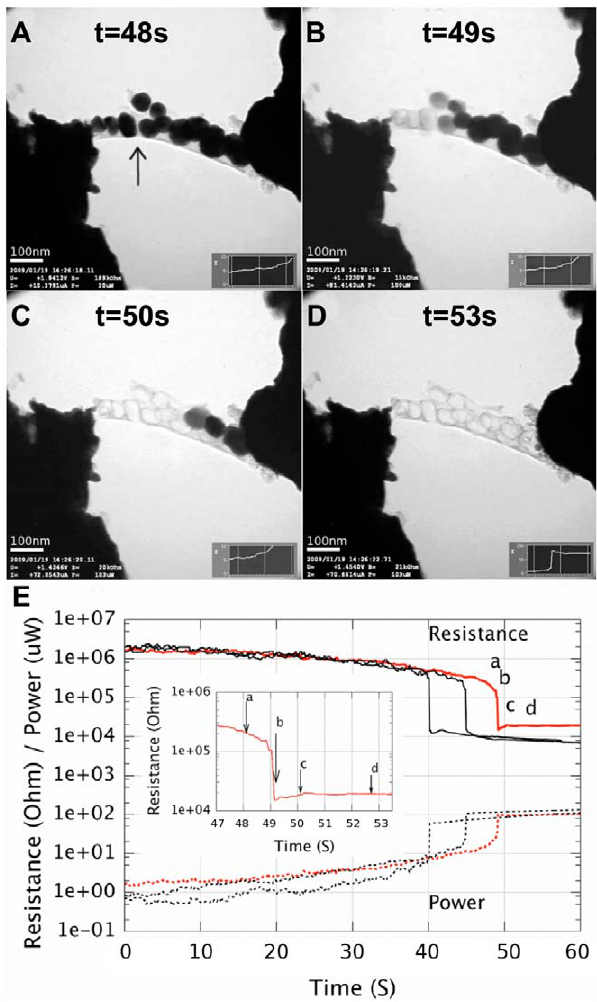
Figure 2. TEM-images showing the carbonization and sintering process correlated to measured electrical data. a) before sintering and b–d) after sintering when the particles melts way in which the remaining carbonized net-like structure is easily seen. The scale bar in all images is 100 nm. e) The corresponding resistance and Joule power as a function of time for three different samples. The lettered curve and the inset curve, correspond to the TEM image sequence.